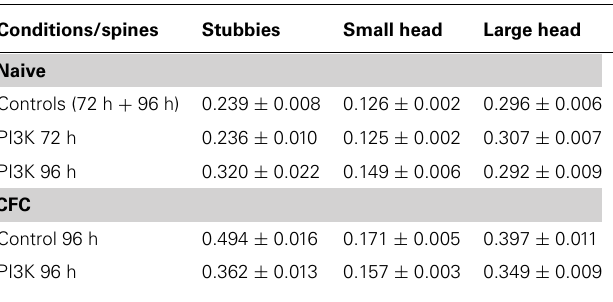
1.77 ± 0.03 spines/ μ m) (Student´s t -test). (C) Cumulative frequency distribution of spine head areas under the experimental conditions. In naive animals, no effect was seen after 72 h, but a significant increased in spine head area was found 96 h after PI3K activation (Kolmogorov–Smirnov, p < 0.001), whereas CFC alone induced an even more pronounced shift toward large spine areas. Interestingly, in CFC tested animals, PI3K overactivation reduced spine head areas as compared to the CFC controls (Kolmogorov–Smirnov, p < 0.001).